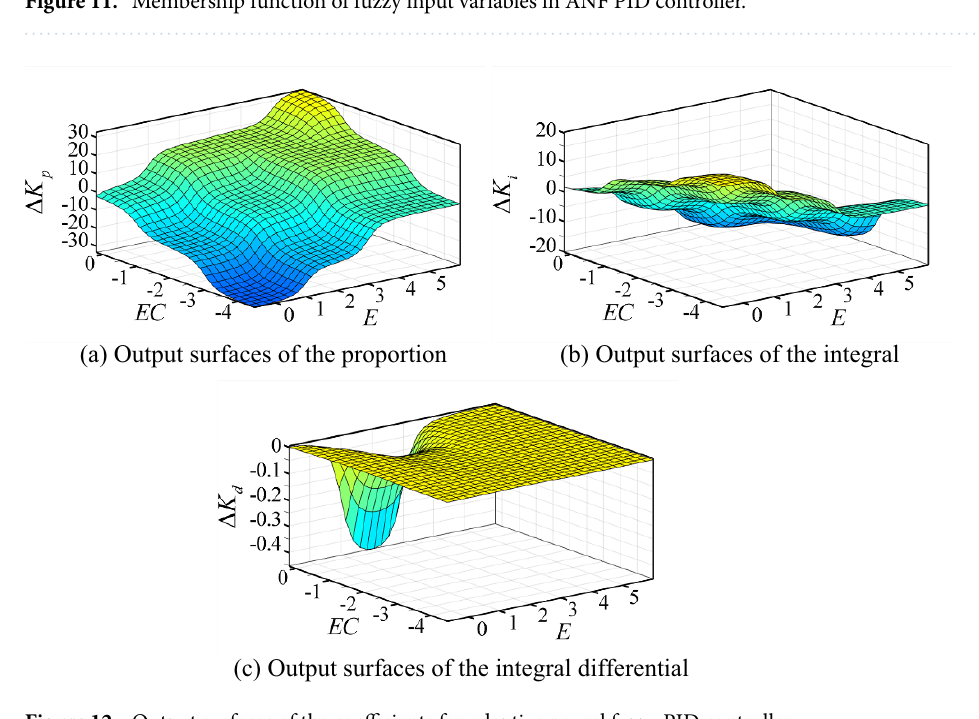
Figure 12. Output surfaces of the coefficients for adaptive neural fuzzy PID